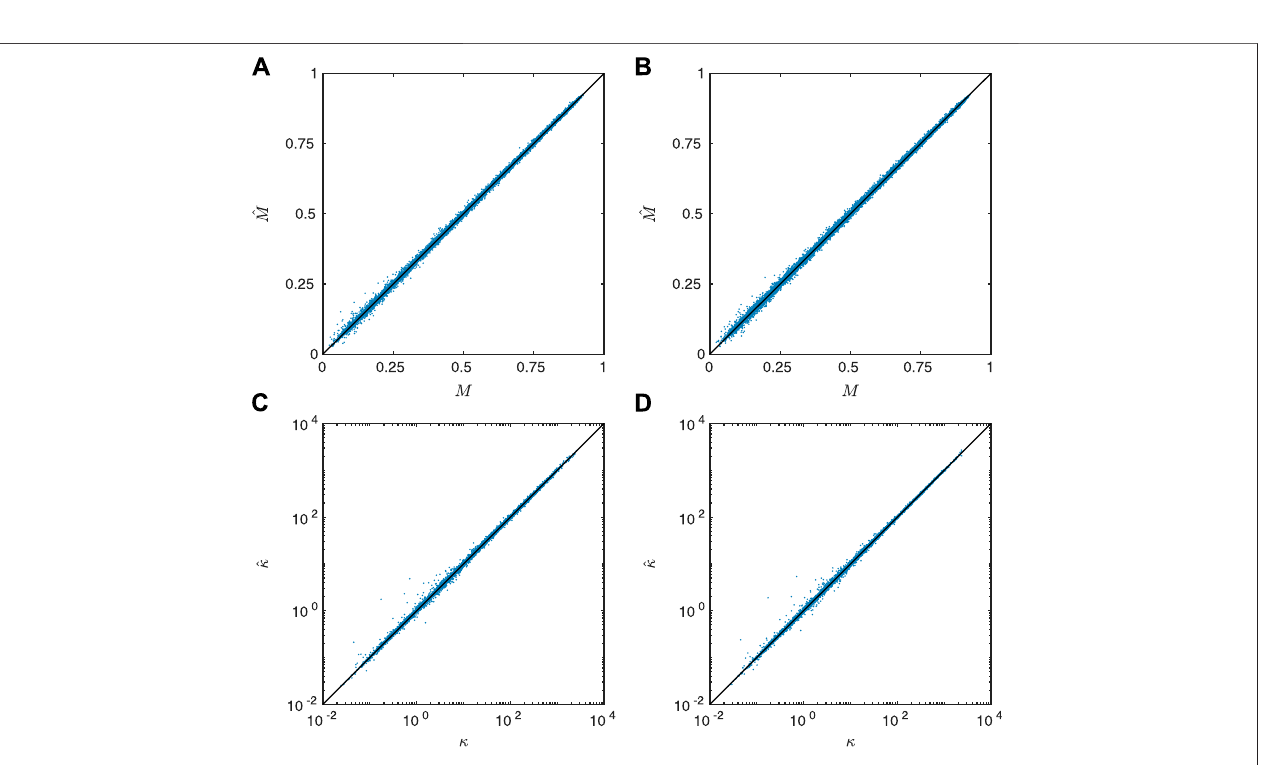
FIGURE 8 | Prediction results using different CNNs, showing (A) prediction of M using an ordinary CNN, (B) prediction of M using a DT-CNN, (C) prediction of κ using an ordinary CNN, and (D) prediction of κ using a DT-CNN. Note that the scatter plots show results based on the test data.